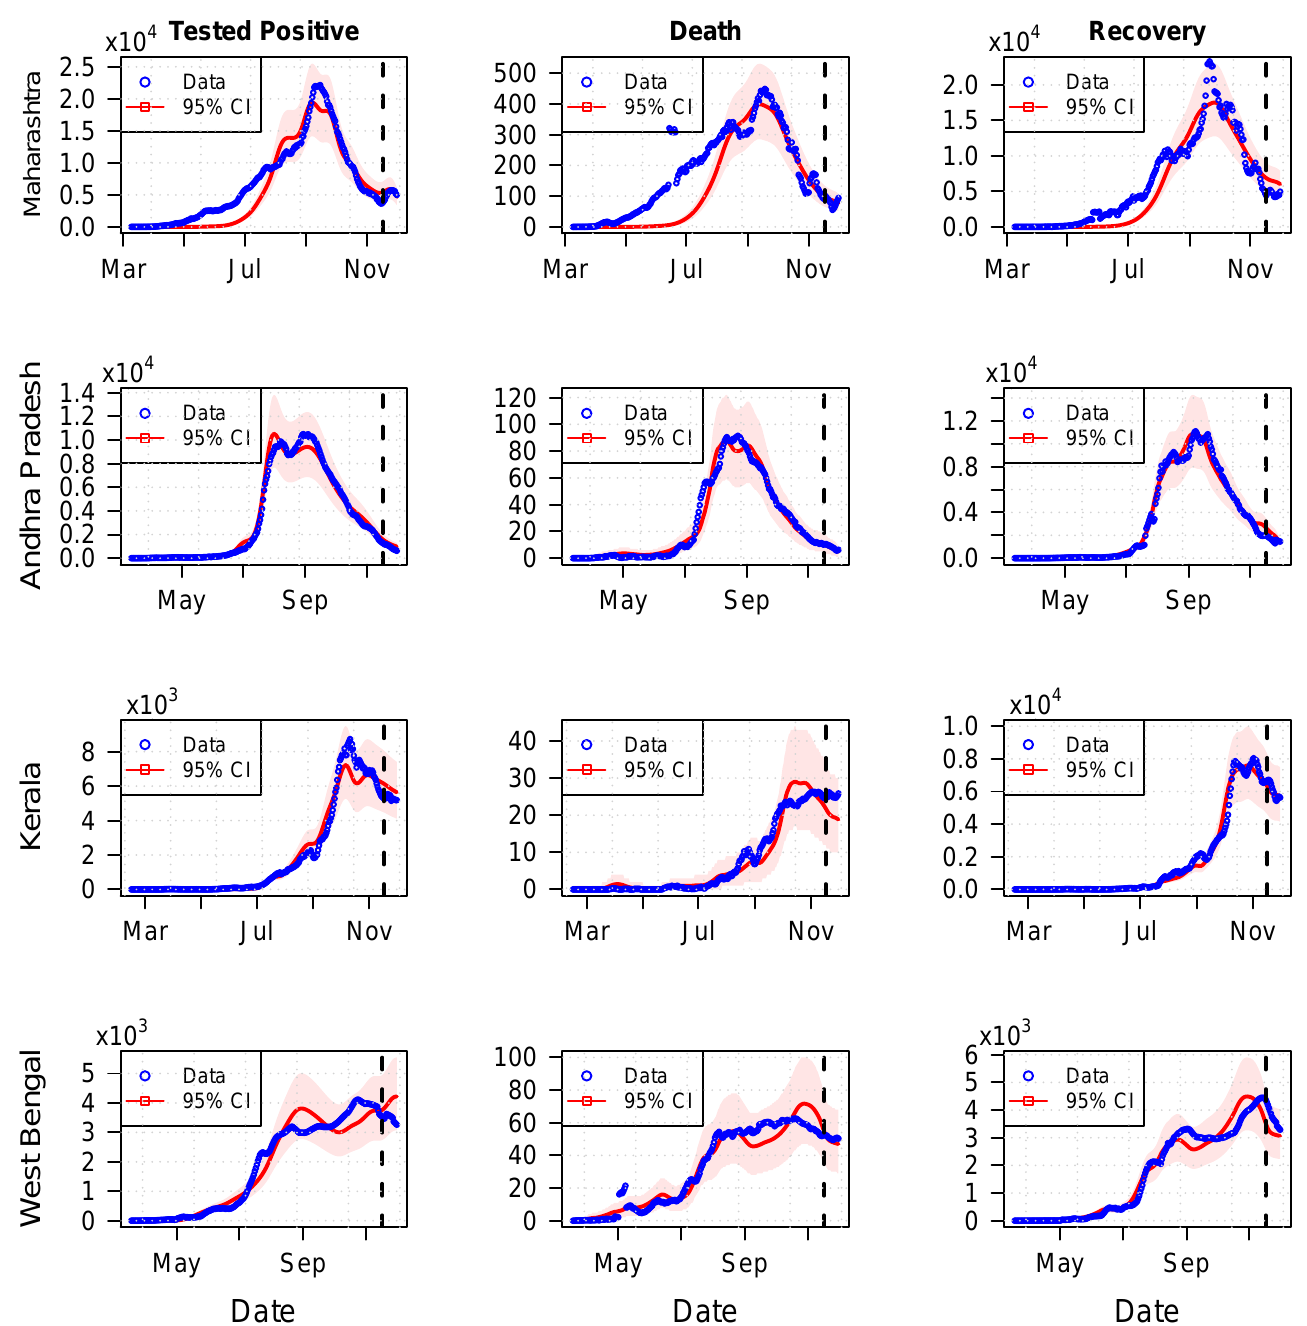
Figure 5. The posterior mean and 95% credible bands for reported cases, death, and recovery cases of other states. The blue circles represent the observed data, the red lines represent the posterior mean and the red bands represent the 95% credible interval. The vertical dashed black lines divide the training and validation